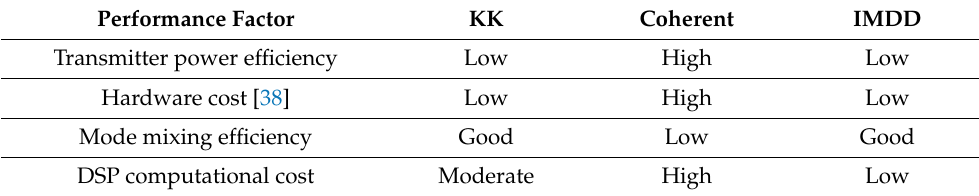
Table 2. Comparison between KK, coherent and